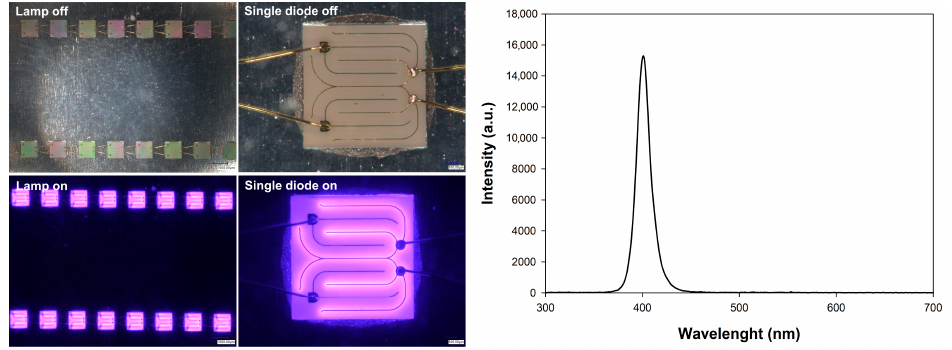
Figure 13. The photo of lamp off/on, single diode off/on, and spectrum of the used COB LED. Measurement of the power and energy consumption of the UV-LED lamp was car- ried out using a GB202 wattmeter (GreenBlue, Maclean Energy, Shenzen, China). The cal- culations of the cost of consumed electricity are based on Eurostat